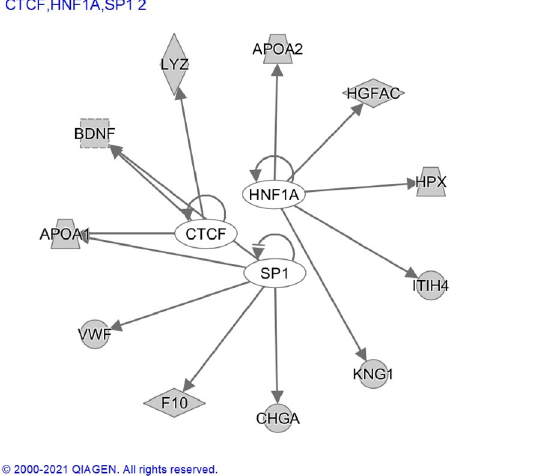
Figure 1. Bioinformatics analysis of the differentially expressed